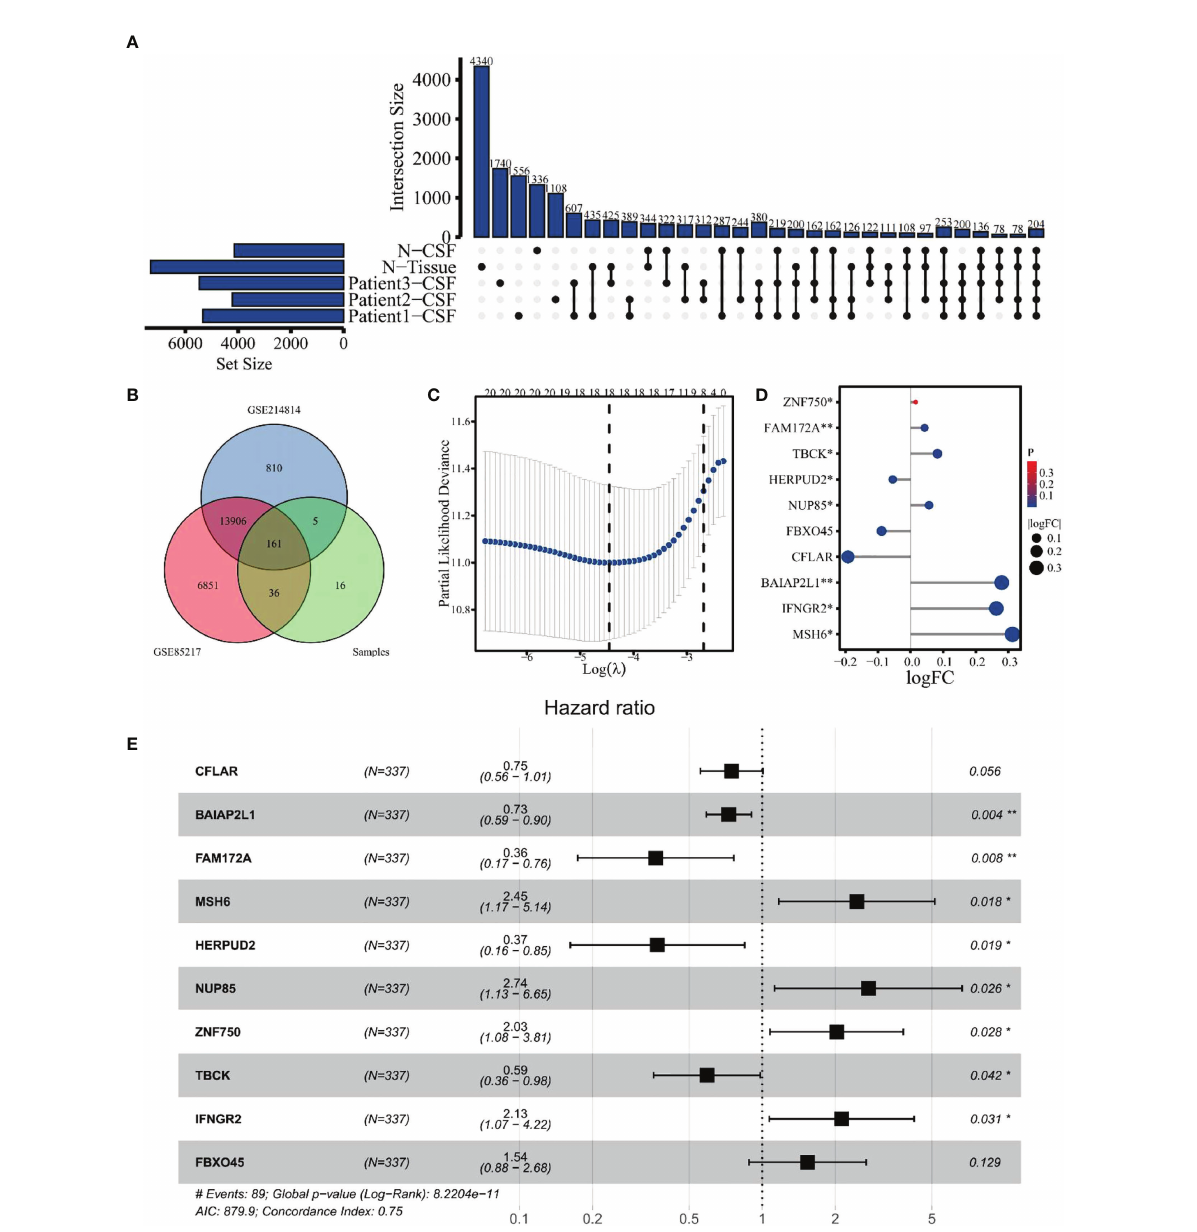
FIGURE 6 Identi fi cation of hub genes for differentially expressed eccDNAs in CSF. (A) A total of 380 differentially expressed eccDNAs between normal and MB in CSF. (B) Venn plot of genes among GSE124814, GSE85217, and data from our cohort. (C) Eighteen genes were selected by Lasso- penalized Cox analysis. (D) Differential expression of 10 hub genes between normal and tumor samples in dataset GSE124814. (E) Ten hub genes associated with OS in the training cohort. The symbol * means FDR adjusted p value for the labeled correlation was less than 0.05, ** means FDR adjusted p value for the labeled correlation was less than